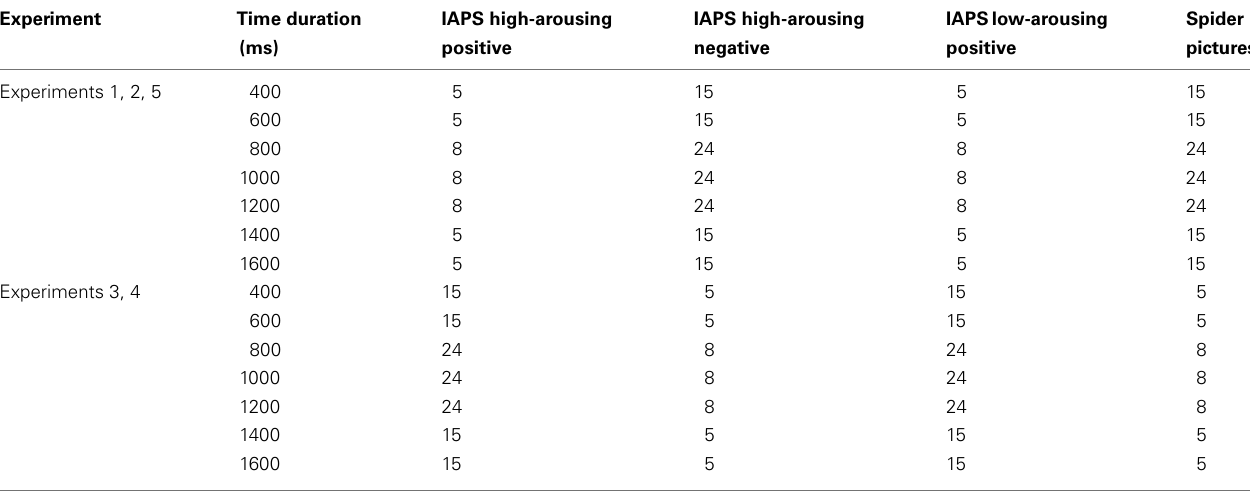
Table 3 | Number of trials per condition.